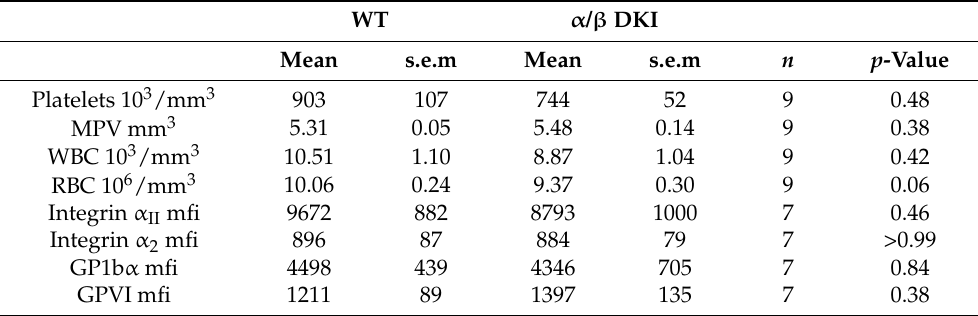
Whole blood counts and platelet surface receptor expression in wild-type and phosphorylation-resistant GSK3 α / β mice. Complete blood counts were conducted using a Pentra ES60 (Horiba) and adjusted for anticoagulant volume. Surface expression of integrin α IIb (CD41), using FITC-conjugated antibodies. Wilcoxon tests were used to test for statistical differences between